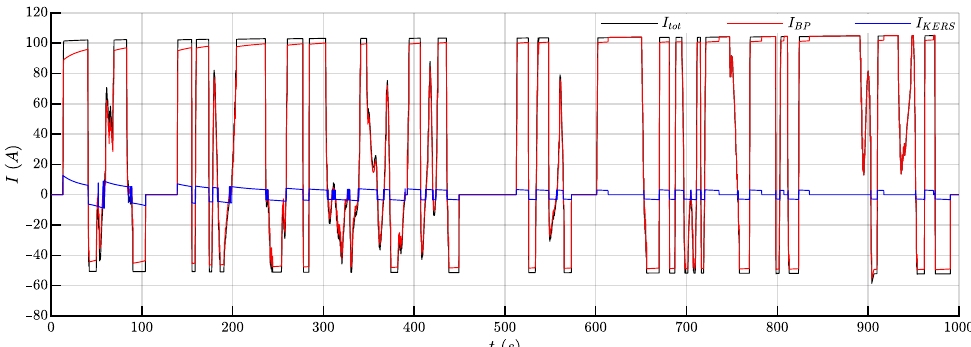
Figure 12. Currents along the whole drive cycle: KERS current (blue), battery pack current (red), and total current